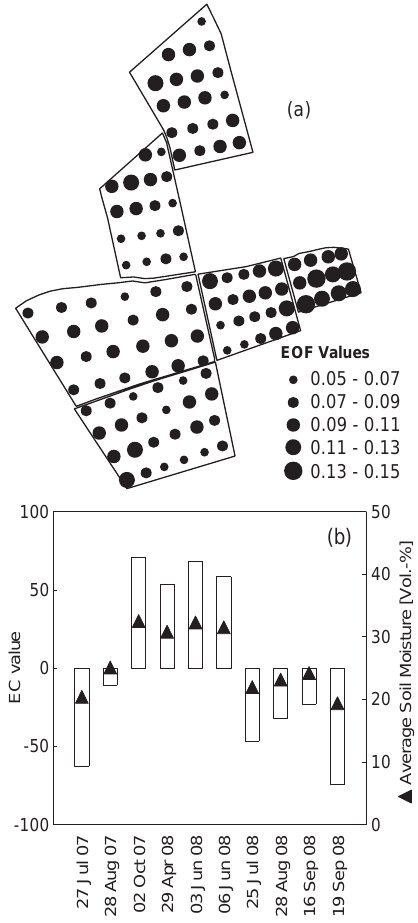
Figure 9. EOF1 (a) and EC1 (b) patterns of the temporal analysis in the arable test site; the Fig. 9. EOF1 (a) and EC1 (b) patterns of the temporal analysis in triangles in (b) represent the average soil the arable test site; the triangles in (b) represent the average soil moisture on the different days. moisture on the different